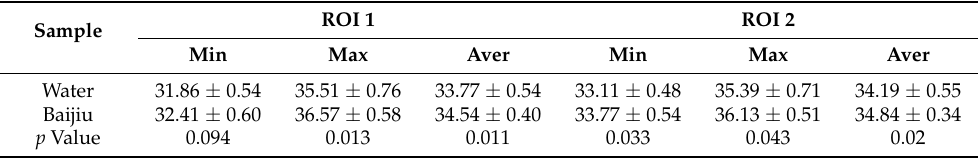
Table 2. Tongue surface temperatures after treated with mineral water and Baijiu ( n = 12).